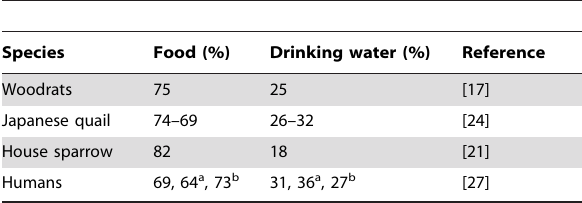
Table 2. Food and drinking water inputs of hydrogen in hair and feathers of different